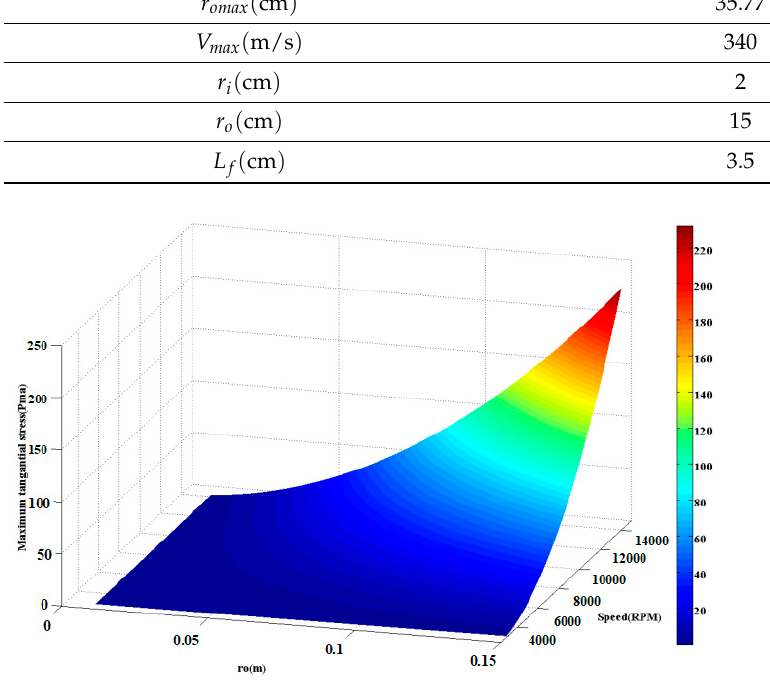
Figure 11. The maximum mechanical stress of the flywheel disk. Table 3. The geometrical dimensions of the designed flywheel disk.